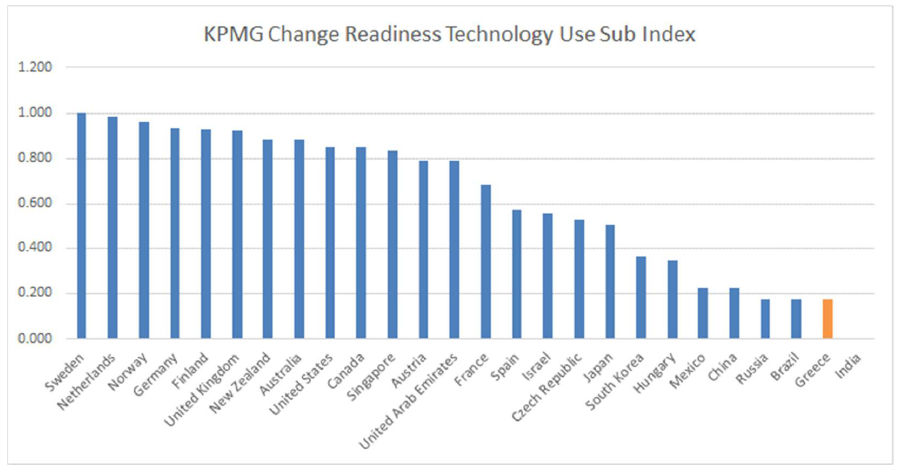
Figure 3. Greece’s AVRI listing in Pillar IV—KPMG Change readiness technology use.